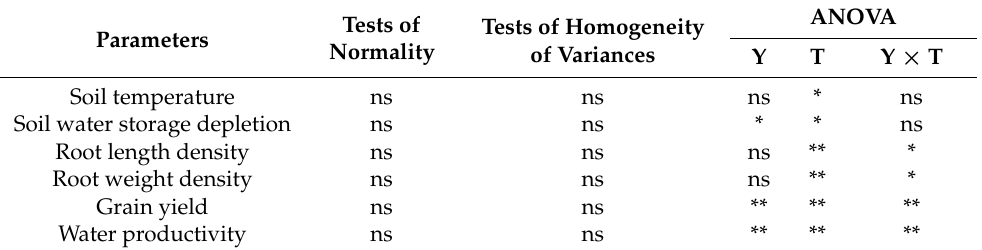
Table 3. Significance of the effects of organic amendment treatments, year, and their interactions on the soil and crop parameters.